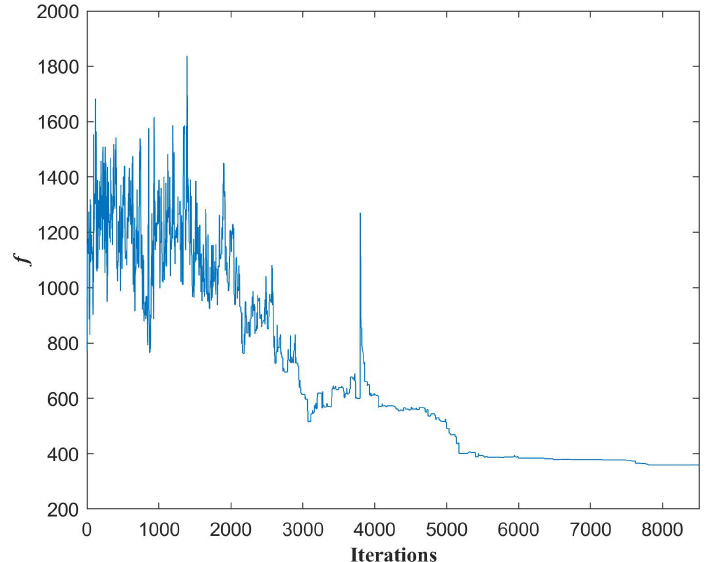
Figure 4. Convergence trend of the A-SA-CPLEX algorithm in the instance s_1.